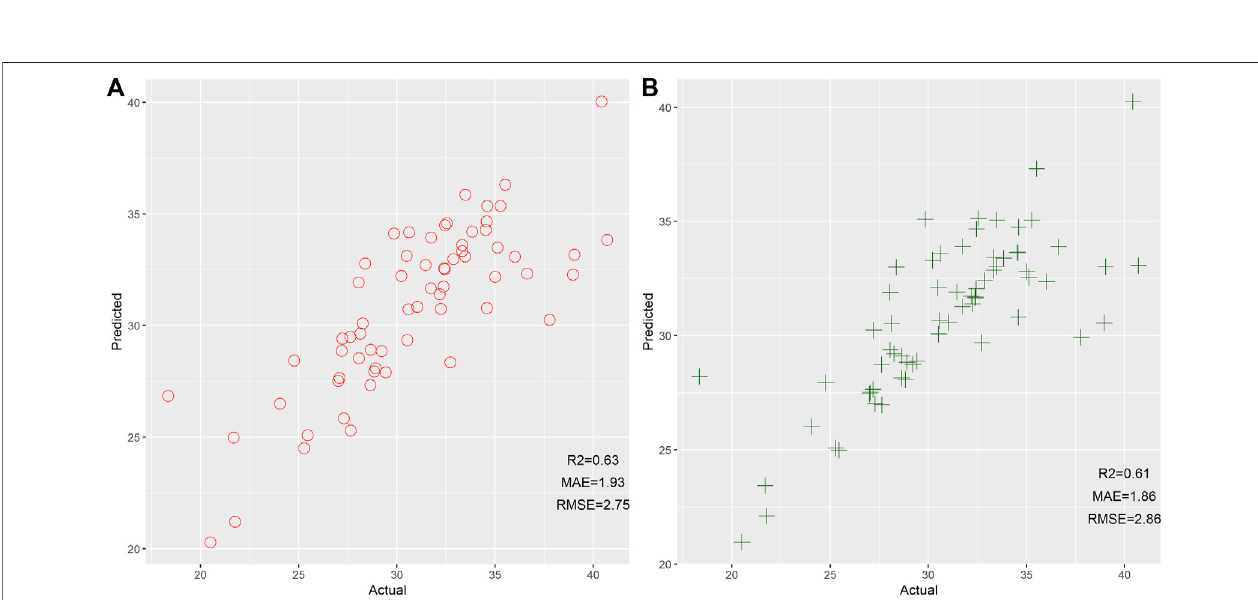
FIGURE 3 | Scatter plot of the predicted age and actual age by the generalized linear model (A) and support vector machine (B) based on 14 mRNAs.